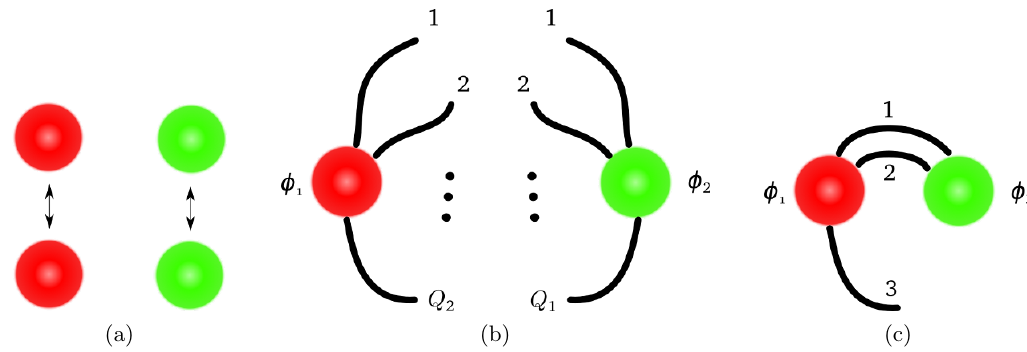
Figure 3 : Intuitive explanation of building a vortex solution in our model. (a) Vortices of the same species repel each other, (b) but for (cid:13) 6 = 0, (cid:30) 1 has Q 2 legs while (cid:30) 2 has Q 1